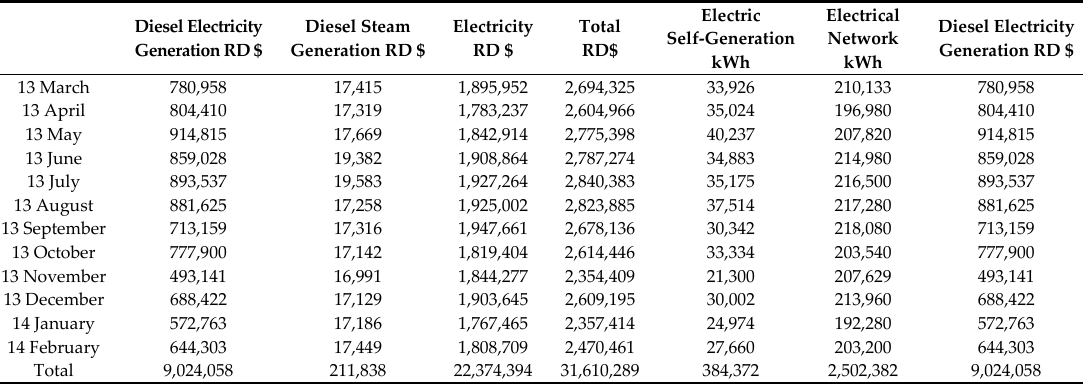
Table 1. Data of energy invoices of all the